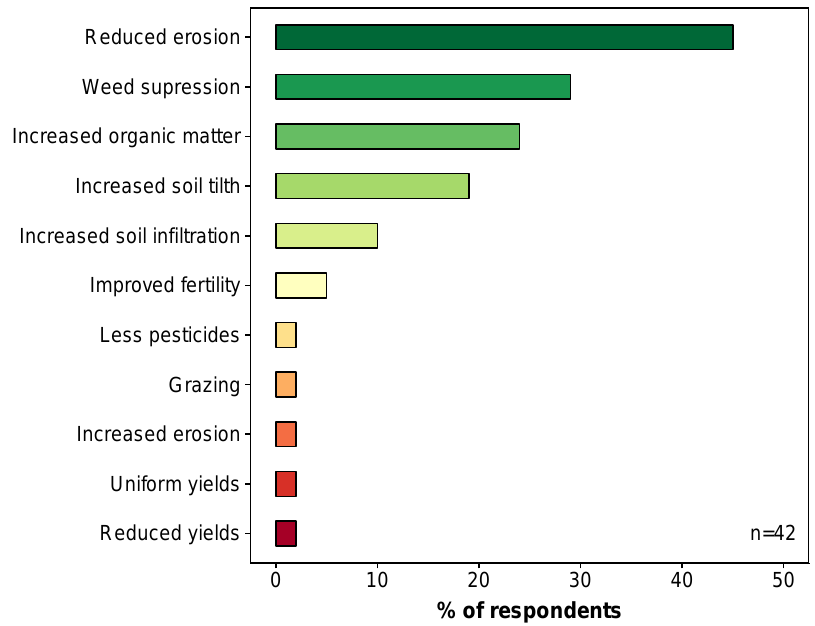
Figure 5. Major observed change(s) after adoption of cover crops in agroecosystems according to Nebraska survey